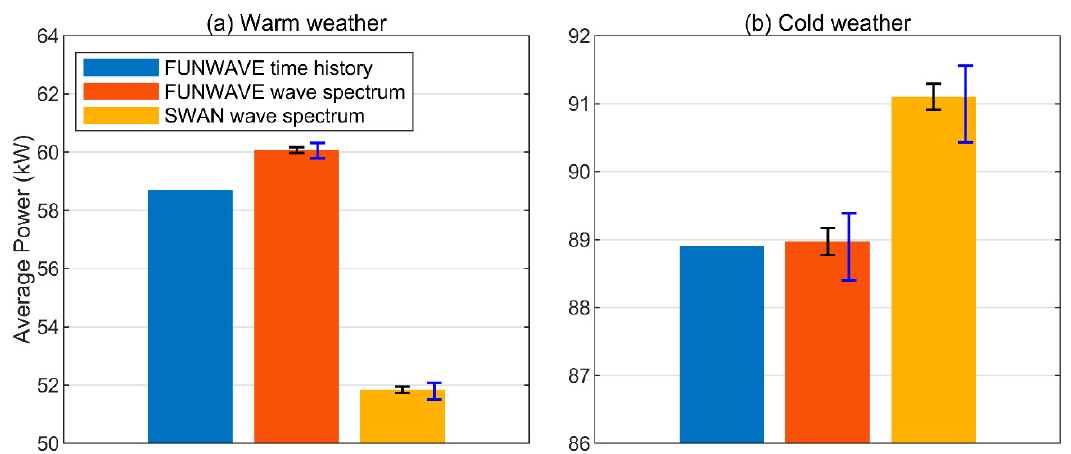
Figure 12. The average power of the WEC farm including all 14 devices in ( a ) warm weather and ( b ) cold weather months. The column bars are colored by the type of input used in the WEC-Sim simulations. Black error bar: 95% CI; blue error bar: minimum to maximum value range.